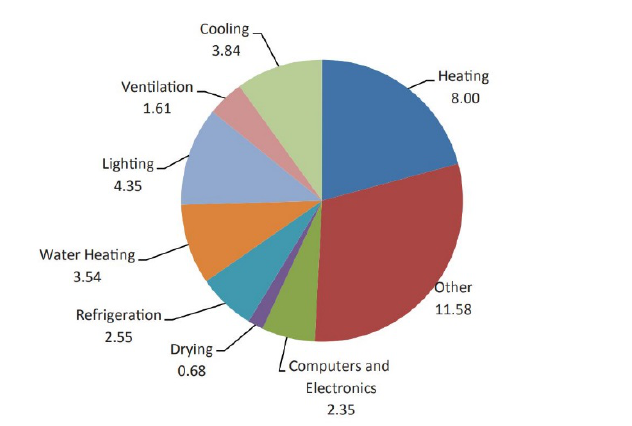
Figure 1 Total primary energy use in buildings (URL